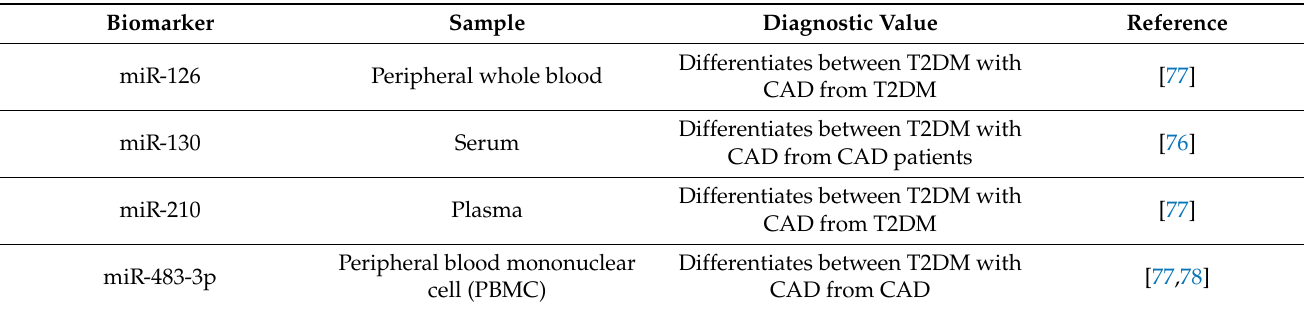
Table 1. The miRNAs that are involved in macrovascular